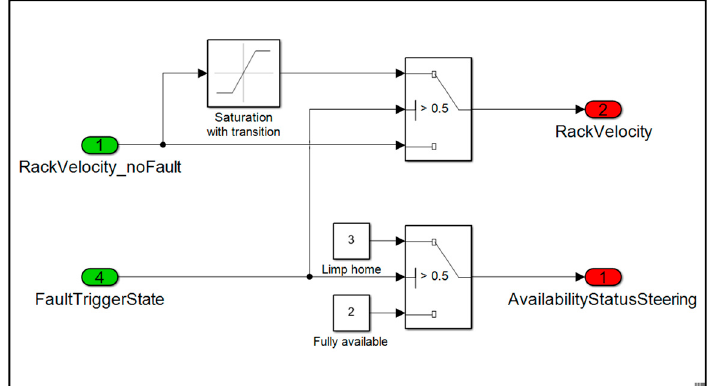
Figure 5. Concept of fault handling in the steering system.